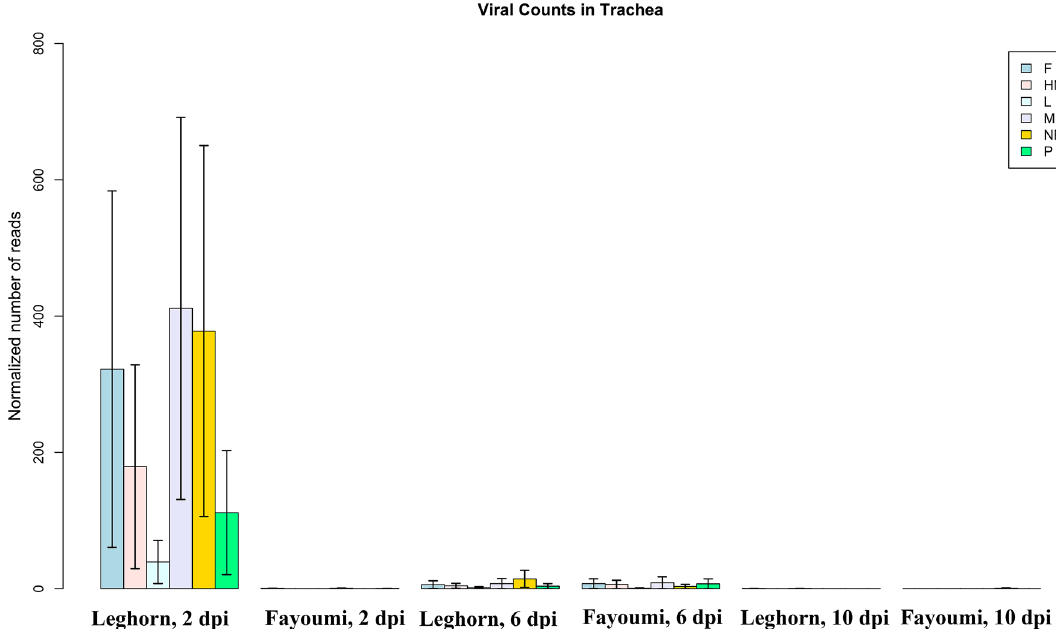
Figure 1. Normalized number of reads that aligned to specific gene segments of the La Sota Newcastle Disease viral genome found in the trachea; epithelium transcriptome: Fusion glycoprotein (F), Hemagglutinin- neuraminidase (HN), RNA-directed RNA polymerase L (L), Matrix protein (M), Nucleoprotein (NP), and Phophoprotein (P). Reads were extracted from treated individuals by genetic line and time point and aligned to the NDV La Sota genome. Bars indicate normalized number of reads with standard error. A higher number of reads aligned to the viral genome in Leghorn at 2 dpi, while at 6 dpi both lines observed detected viral transcripts, with no reads detectable in either line at 10